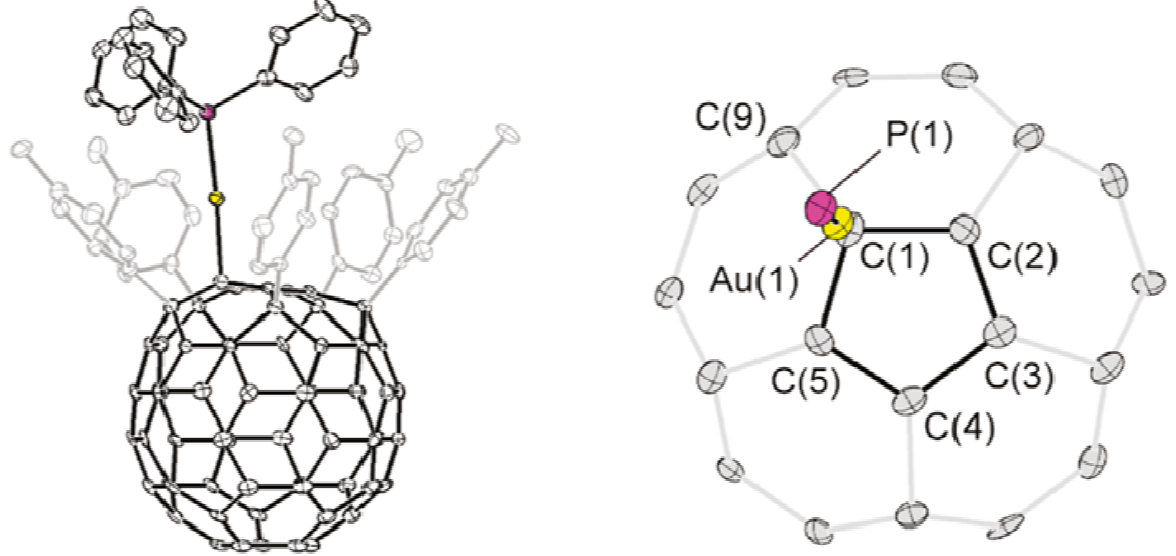
Figure 8. Rubin’s proposition for a η 1 to η 3 hapticity change in the case of a gold complex (Reproduced from [39] with permission).